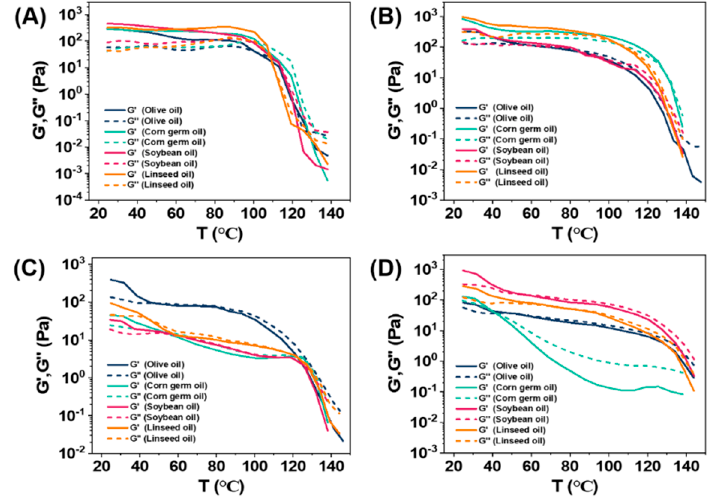
Figure 3. Dependence of the storage modulus (G’) and loss modulus (G ″ ) with the temperature for a gelator mass fraction of corresponding MGC in four vegetable oils: ( A ) C8-lys-C8, ( B ) C10-lys-C10, ( C ) C12-lys-C12, and ( D ) C14-lys-C14.